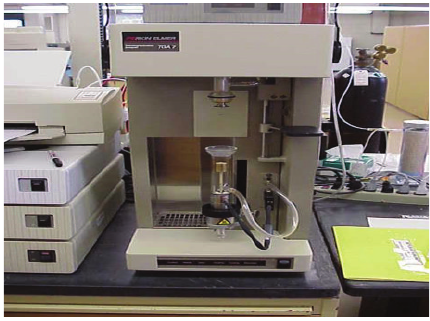
Figure 3: A thermogravimetric analyzer.